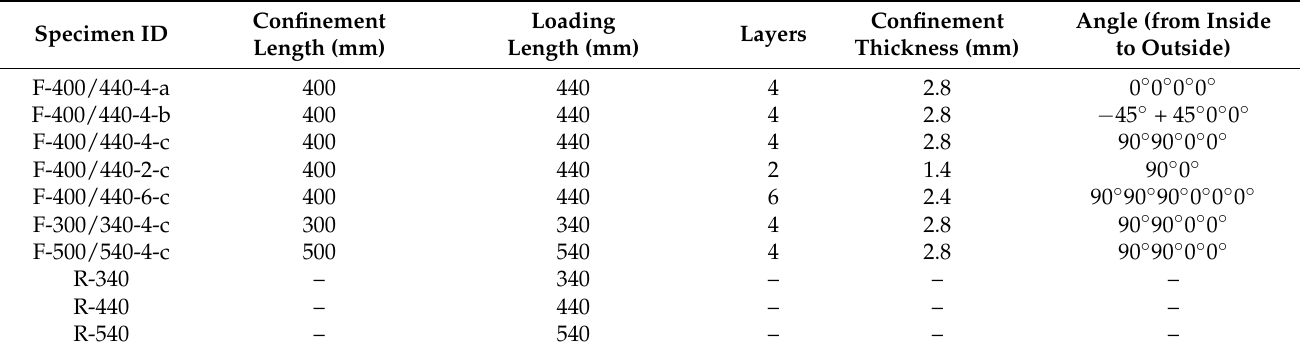
Table 4. Monotonic loading specimens.